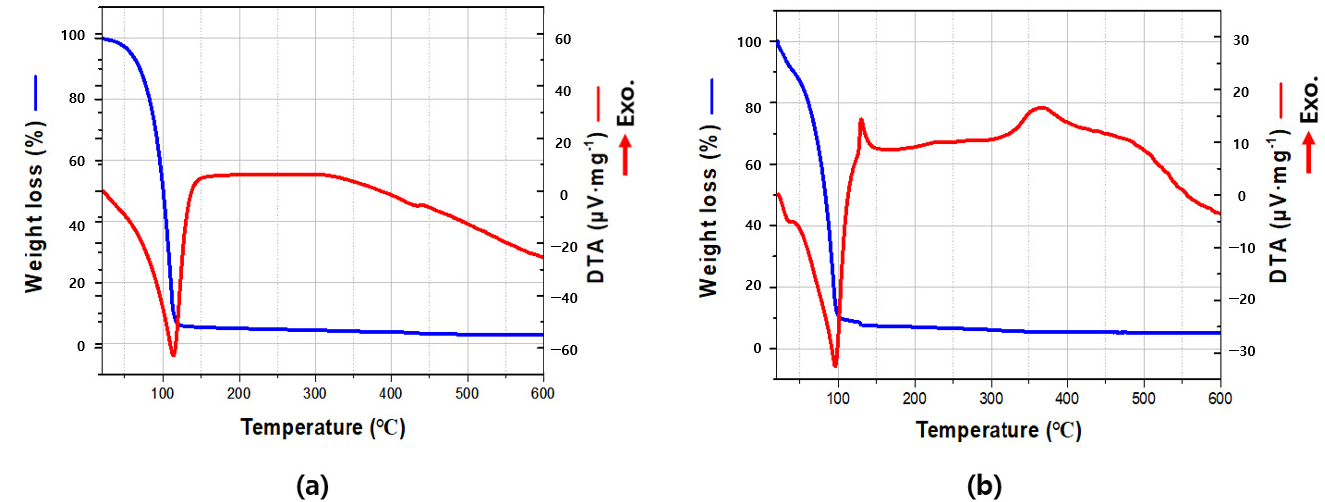
Figure 3. TG-DTA results of ( a ) con-ZTO and ( b ) self-ZTO solutions.